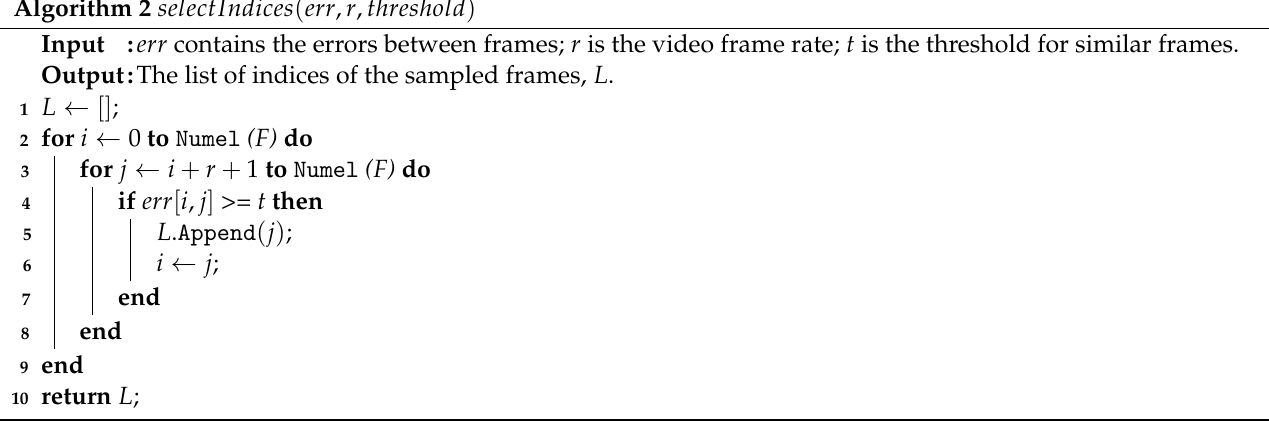
Algorithm 2 selectIndices ( err , r , threshold